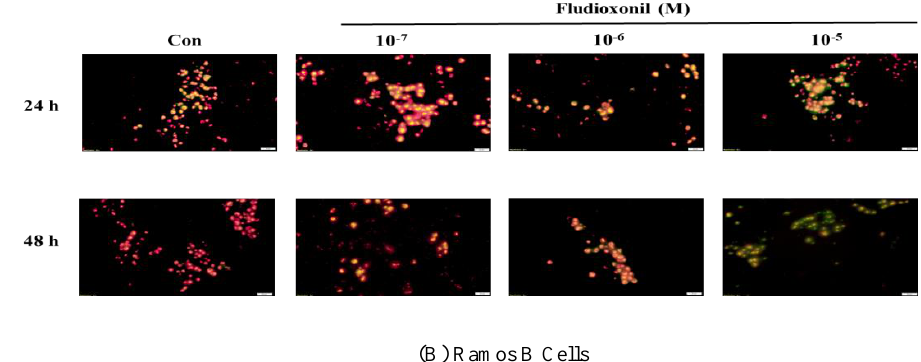
Figure 5. Detection of mitochondrial membrane potential by JC-1 staining after fludioxonil treatment. Decrease of aggregate red fluorescence and increase of green fluorescence indicate a loss in mitochondrial membrane potential. ( A ) Jurkat T cells and ( B ) Ramos B cells treated with 10 − 7 –10 − 5 M fludioxonil for 24 and 48 h. Each panel is representative of three separate experiments, and these results are merged with green and red fluorescence. Scale bar = 20 µ